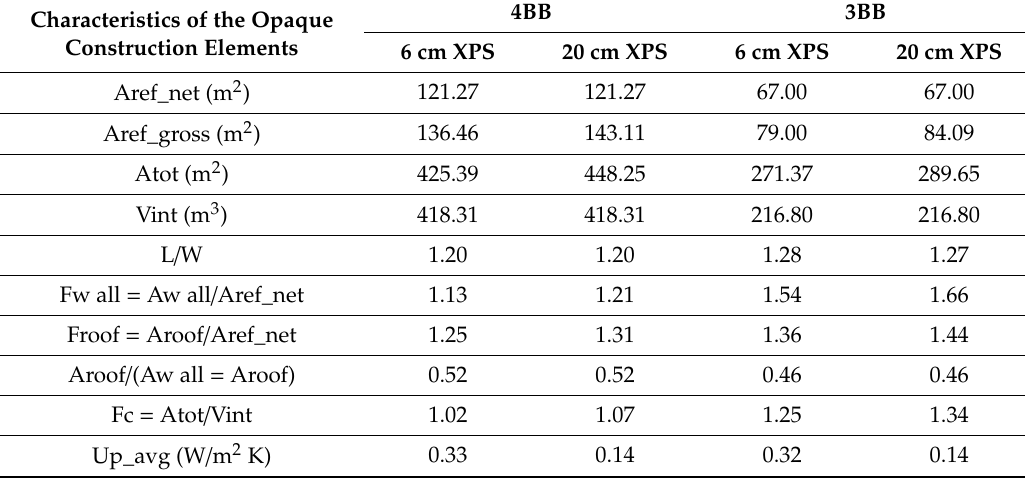
Table 2. Shape factor, other design ratios for the usable floor area and average thermal transmittance. Characteristics of the